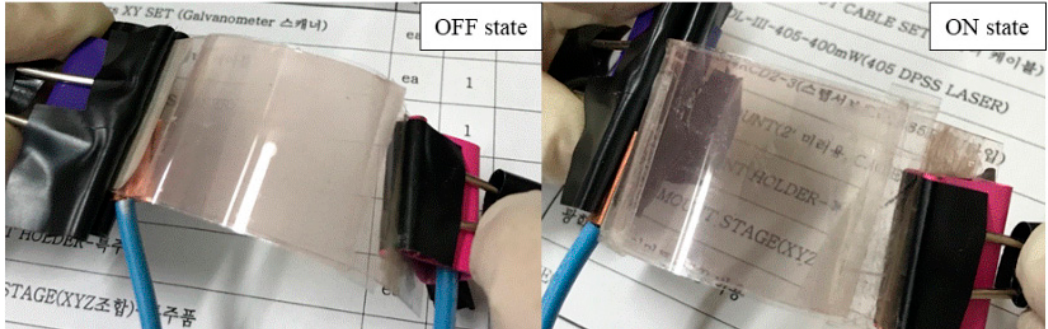
Figure 11. Photographs of Cu–Ni electrode-based flexible PDLC smart windows at 2 states: OFF state and ON state.